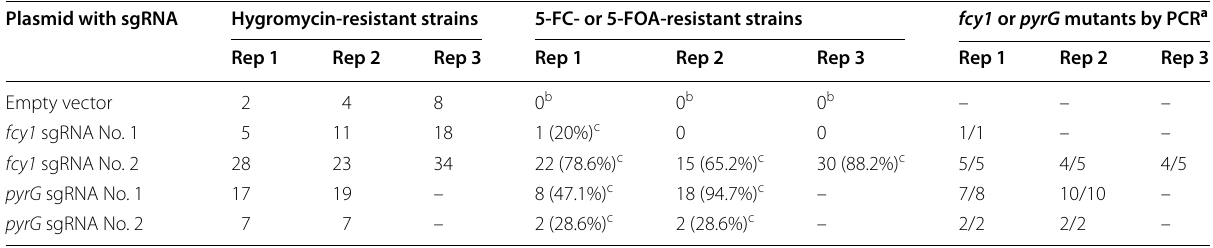
a The number of mutants which can be identified by difference size, or no amplified, bands compared to wild-type control were observed in the genomic PCR experiment (Additional file 1: Fig. S2A and B) b The number of 5-FC- or 5-FOA-resistant strains c Percentage of 5-FC- or 5-FOA-resistant strains from the total number of hygromycin-resistant strains